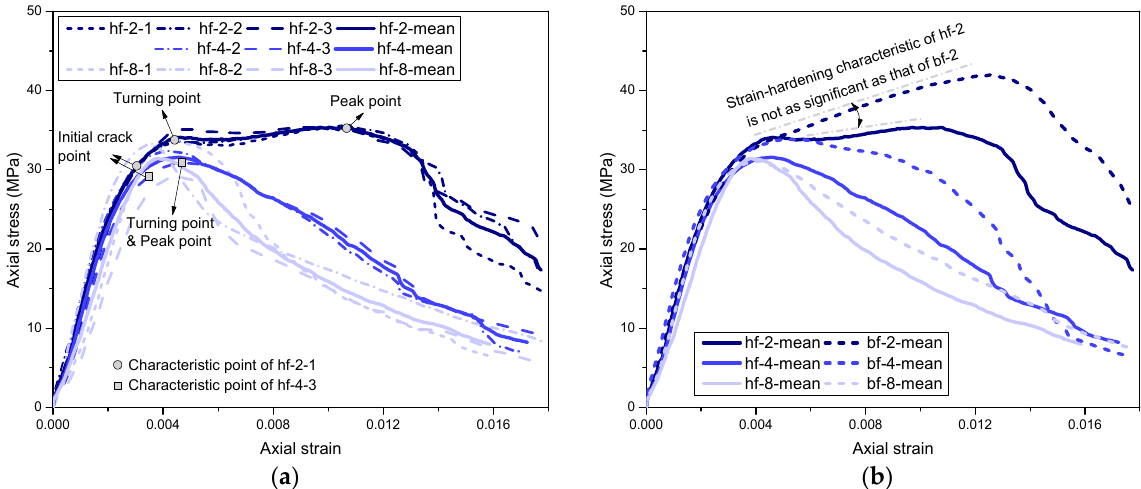
Figure 4. Axial stress–axial strain curves of different types of cylinders: ( a ) hf series; ( b ) comparison of hf series and bf series.